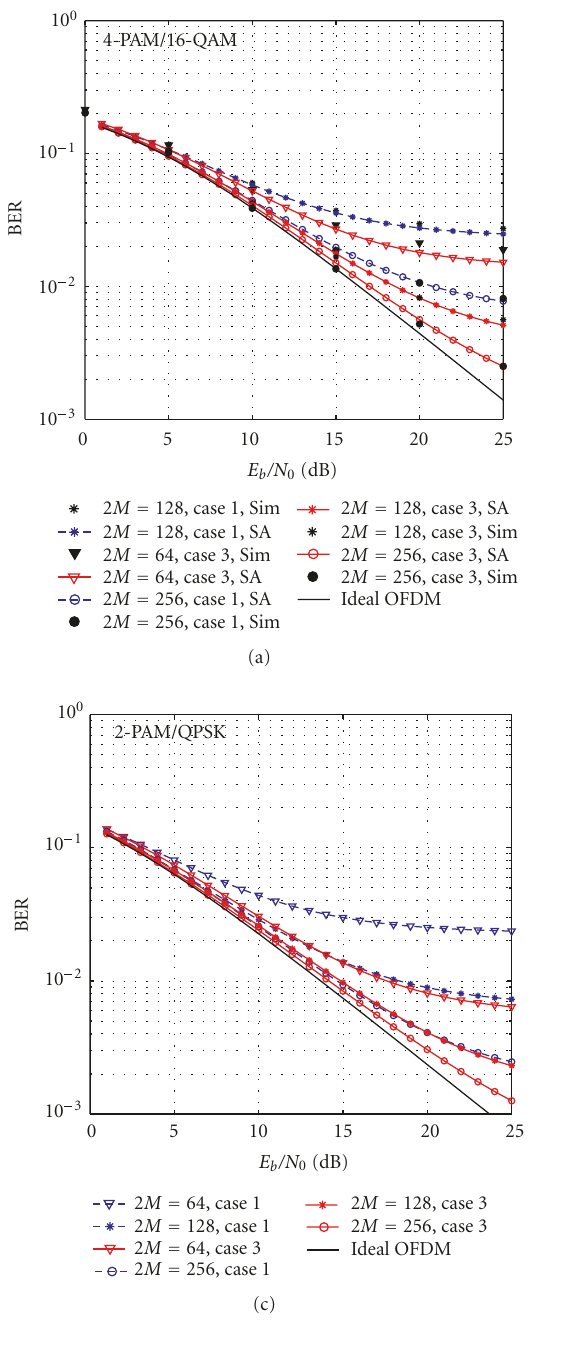
Figure 8: Uncoded BER results for AP-SCE with a quasi-static ITU-R Vehicular-A channel model and 20 MHz bandwidth. (a) Comparison of time domain simulations (Sim) and semi-analytic model (SA) for ZF 4-PAM. (b) Comparison of ZF and MSE criteria with 4-PAM based on time domain simulations. (c) Semi-analytic performance of ZF 2-PAM. (d) Semi-analytic performance of ZF 8-PAM. Ideal OFDM (using corresponding square-constellation QAM, without guard interval overhead) included in all figures as a